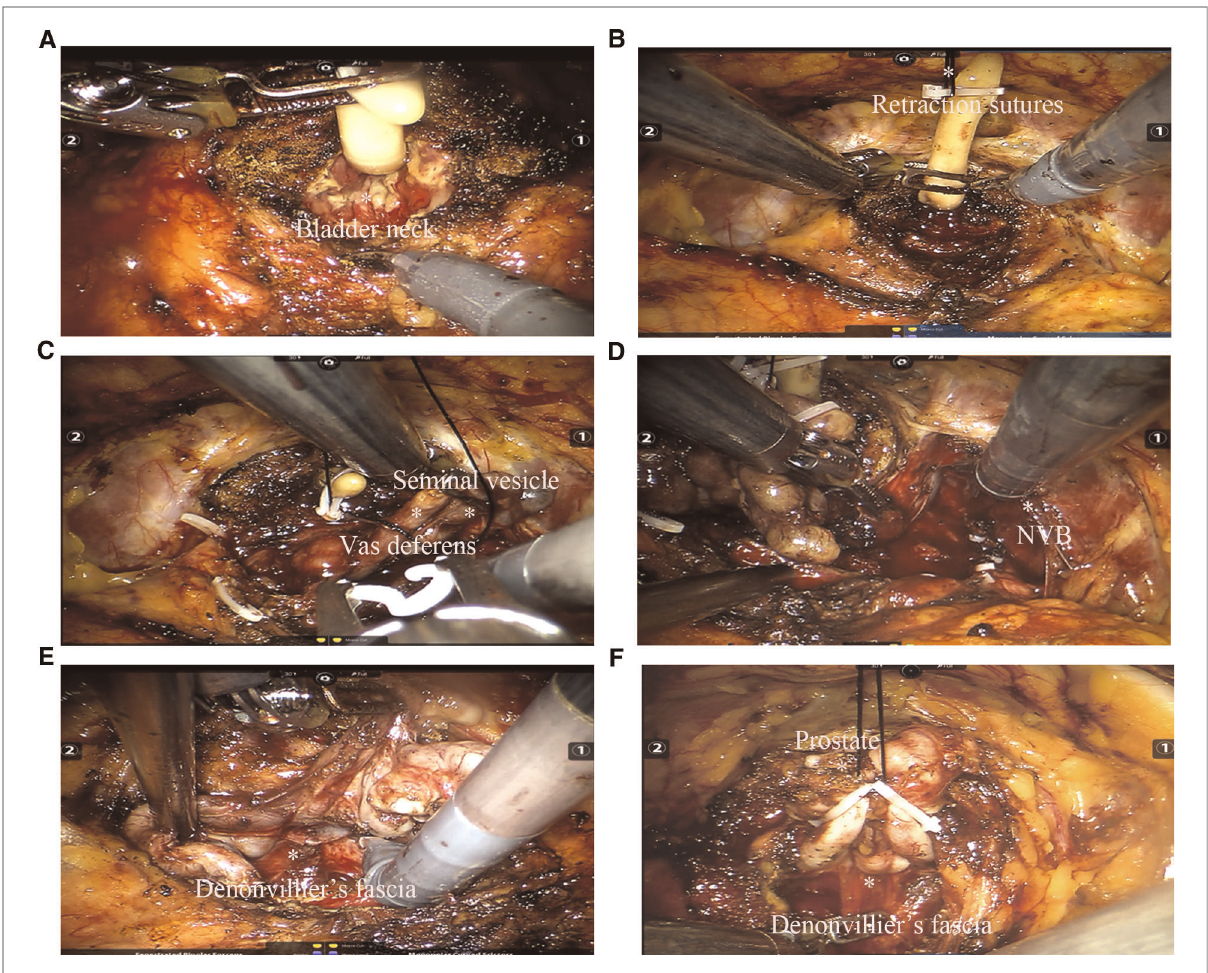
FIGURE 3 Key procedure of the extraperitoneal tissue retraction technique. ( A ) Because the assistance of the fourth arm in extraperitoneal pure sp-RARP was absent, one robotic arm needed to act as a retractor to stretch the catheter. ( B ) The retraction sutures and catheter were fi xed together during dissection of the bladder neck. ( C ) The retraction sutures and prostate needed to be fi xed together, which facilitates the dissection of the vas deferens and seminal vesicles. ( D ) During dissection of the NVB, the prostate, seminal vesicles, and vas deferens were suspended. ( E ) Use of robotic arms to retract the ampullae and their attached seminal vesicles anterior to help identify the anterior rectal wall in extraperitoneal pure sp-RARP. ( F ) The prostate, seminal vesicles, and vas deferens were retracted to expose the visual fi eld and visualize Denonvilliers ’ fascia. sp- RARP: single-port robotic-assisted radical prostatectomy; NVB: neurovascular